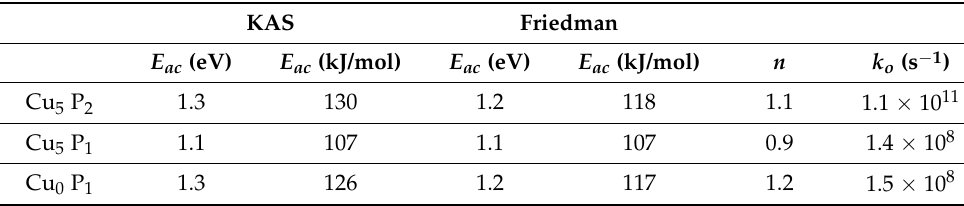
Table 1. Average values of the kinetic parameters obtained for the thermally activated processes underlying P 1 (for Cu 5 and Cu 0 samples) and P 2 .